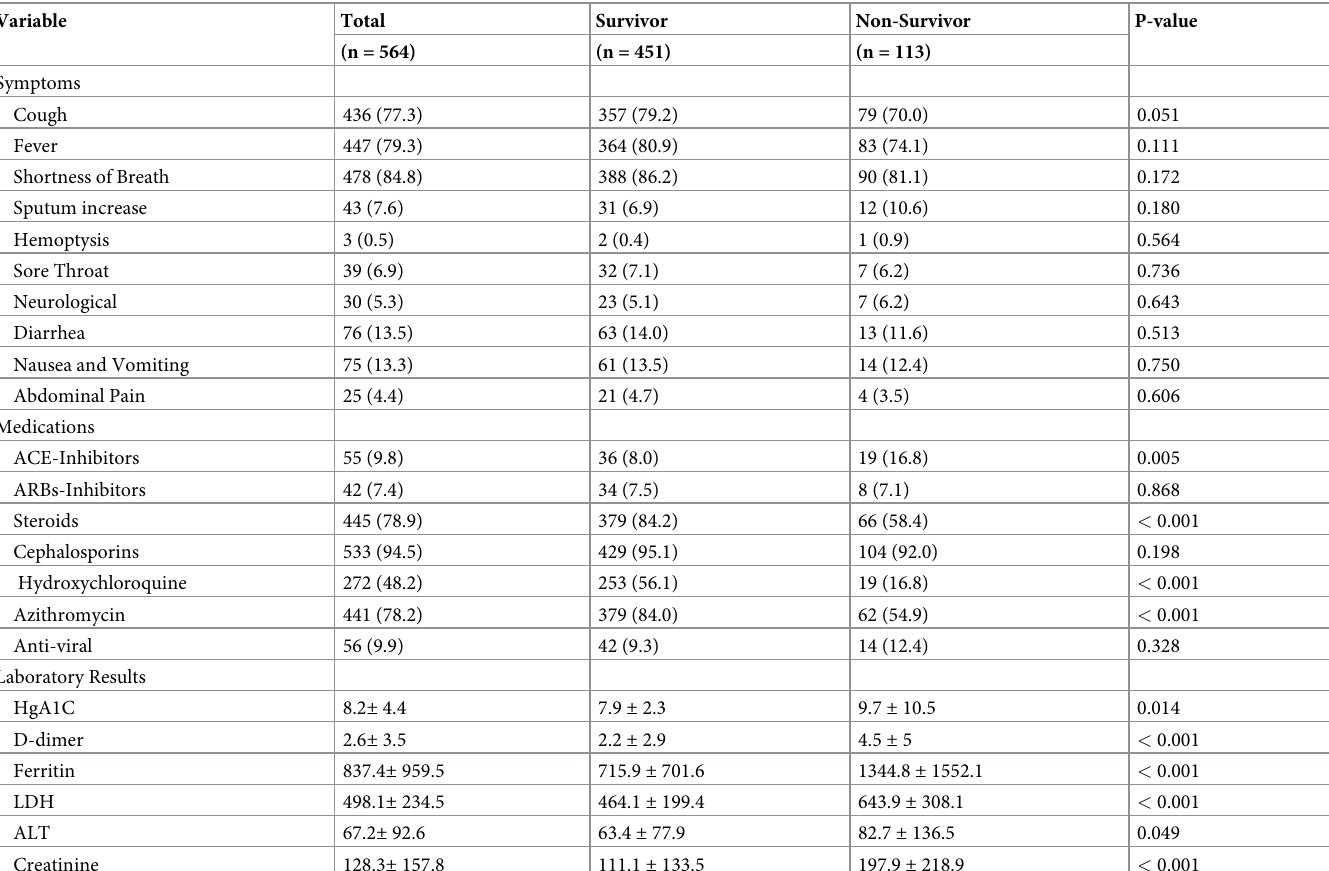
Table 2. The symptoms, medications, laboratory results and outcomes among survivors and non-survivors of patients with COVID-19.